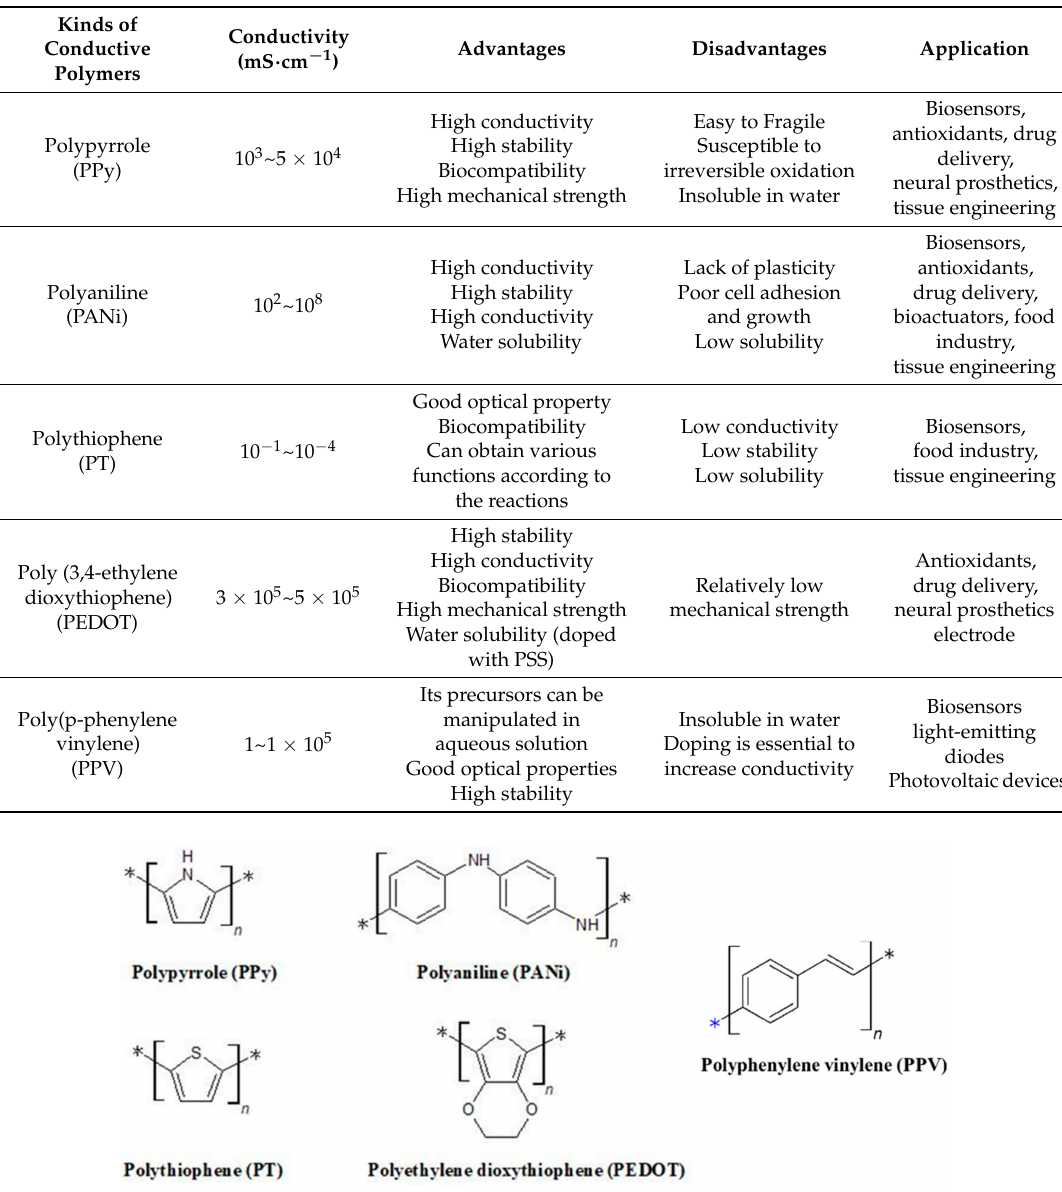
Table 2. Bulk Properties of Conductive Polymers.